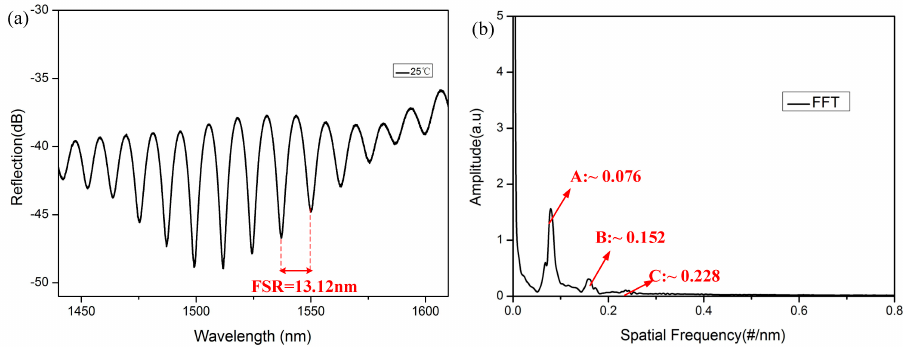
Figure 3. ( a ) Reflection spectrum of the device ( L = 60 µ m); ( b ) the FFT.